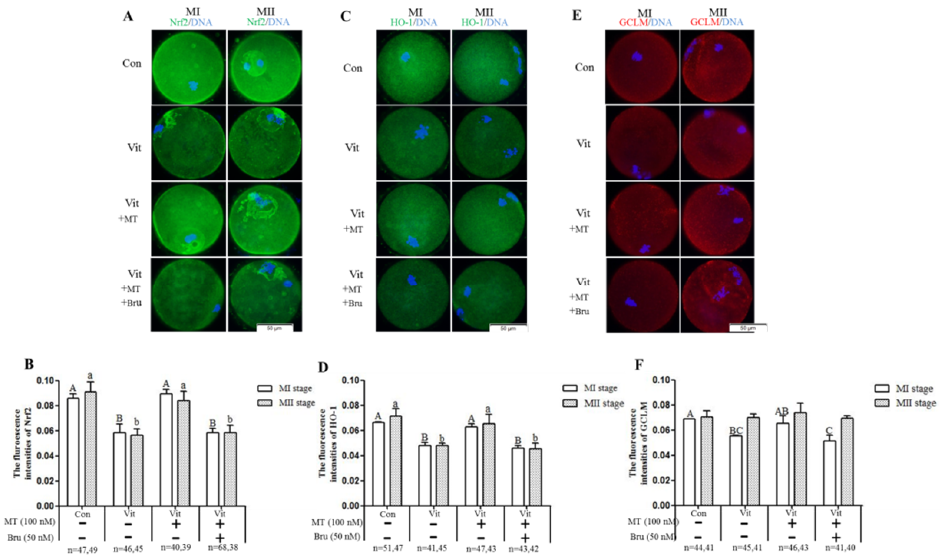
Figure 8. Effects of melatonin (MT) and Brusatol (Bru) on the expression of the Nrf2 pathway-related antioxidant proteins during in vitro maturation of vitrified-warmed mouse GV oocytes. Immunofluorescence of Nrf2 ( A , B ), HO-1 ( C , D ) and GCLM ( E , F ). Data are presented as mean ± SEM of three independent experiments. Values with different superscripts A (a), B (b), and C (c) are different ( p < 0.05) between groups at the same stages. Scale bar = 50 µm. The four experimental groups: control (Con), vitrification (Vit), vitrification + melatonin (Vit + MT), and vitrification + melatonin + Brusatol (Vit + MT + Bru). Notes: MI: metaphase I; MII: metaphase II.